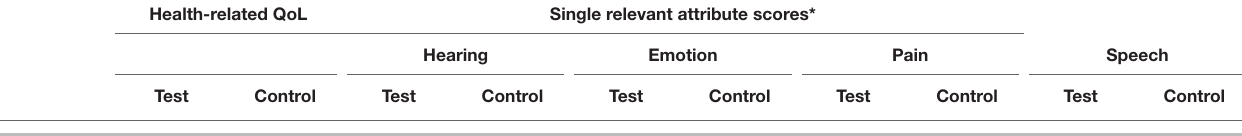
TABLE 7B | Quality of Life measure after 3 years.